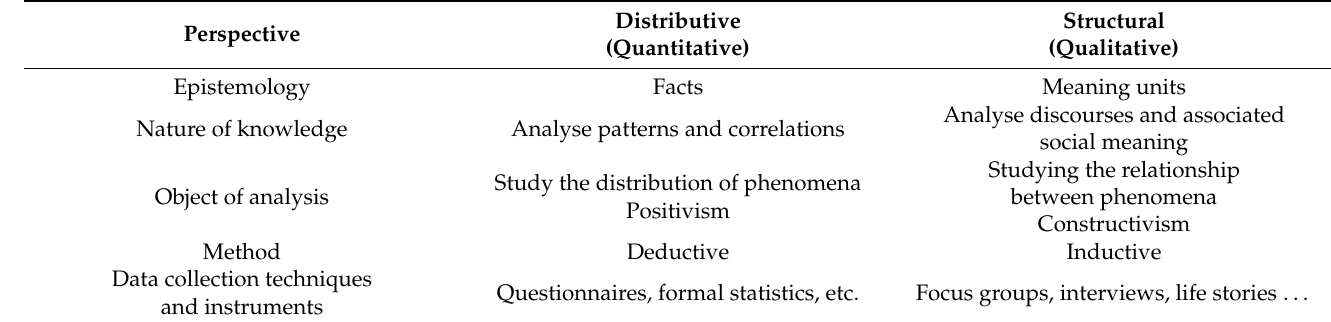
Table 1. Quantitative and qualitative description. Source: Murillo & Mena